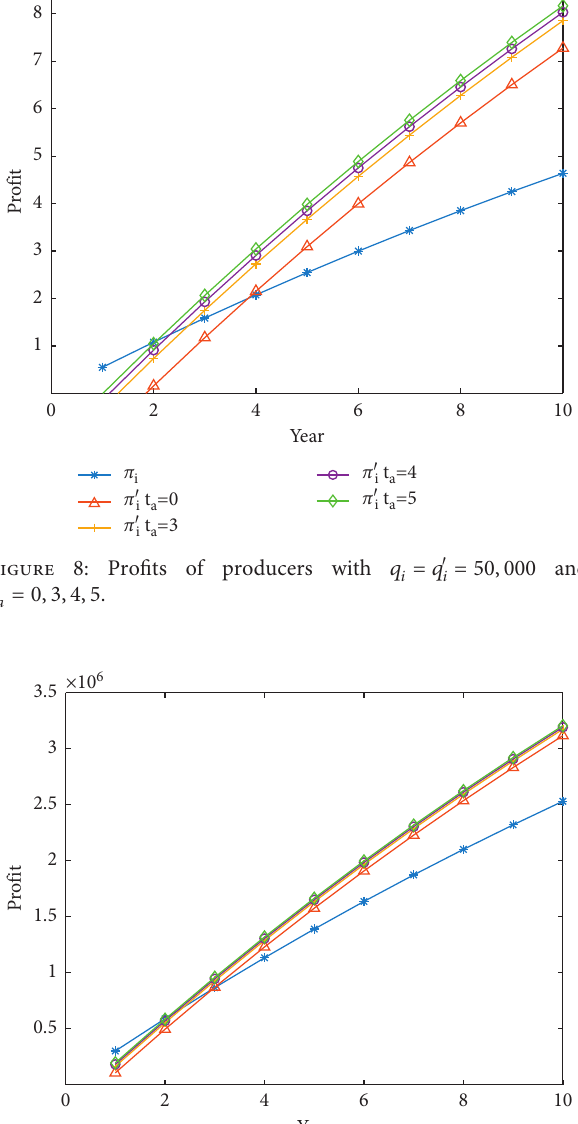
� q � 300 , 000 and j j ′